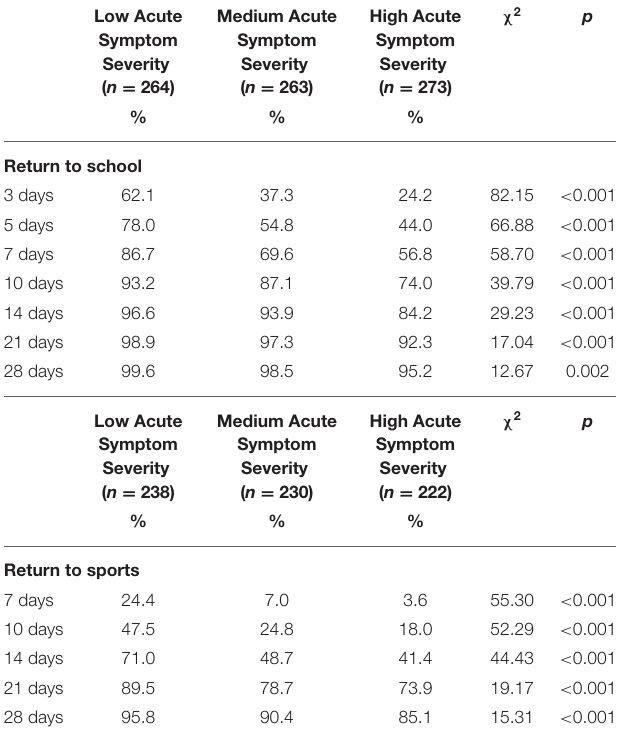
TABLE 3 | Chi-squared analyses comparing the percentage of athletes who returned to school and sports at various time points post injury based on acute symptom